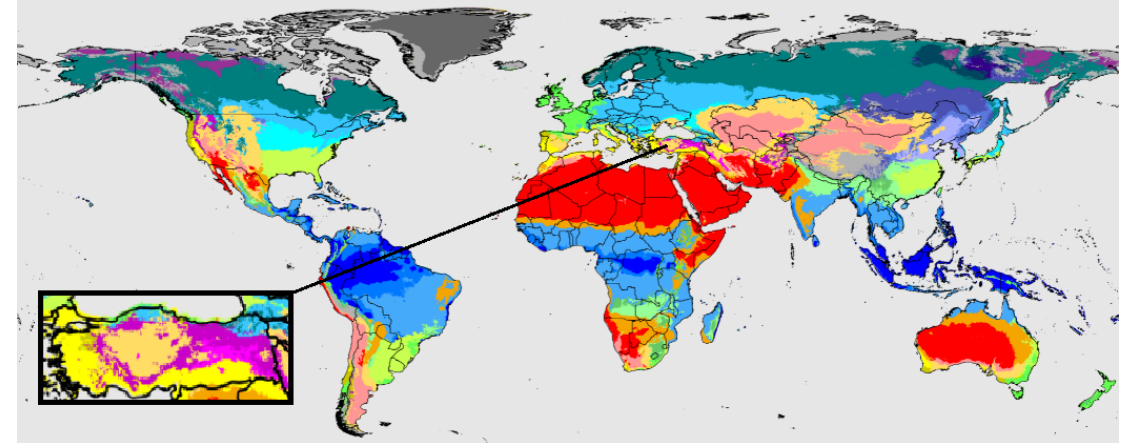
Figure 3. Worldwide locations with similar climate of Turkey [32].